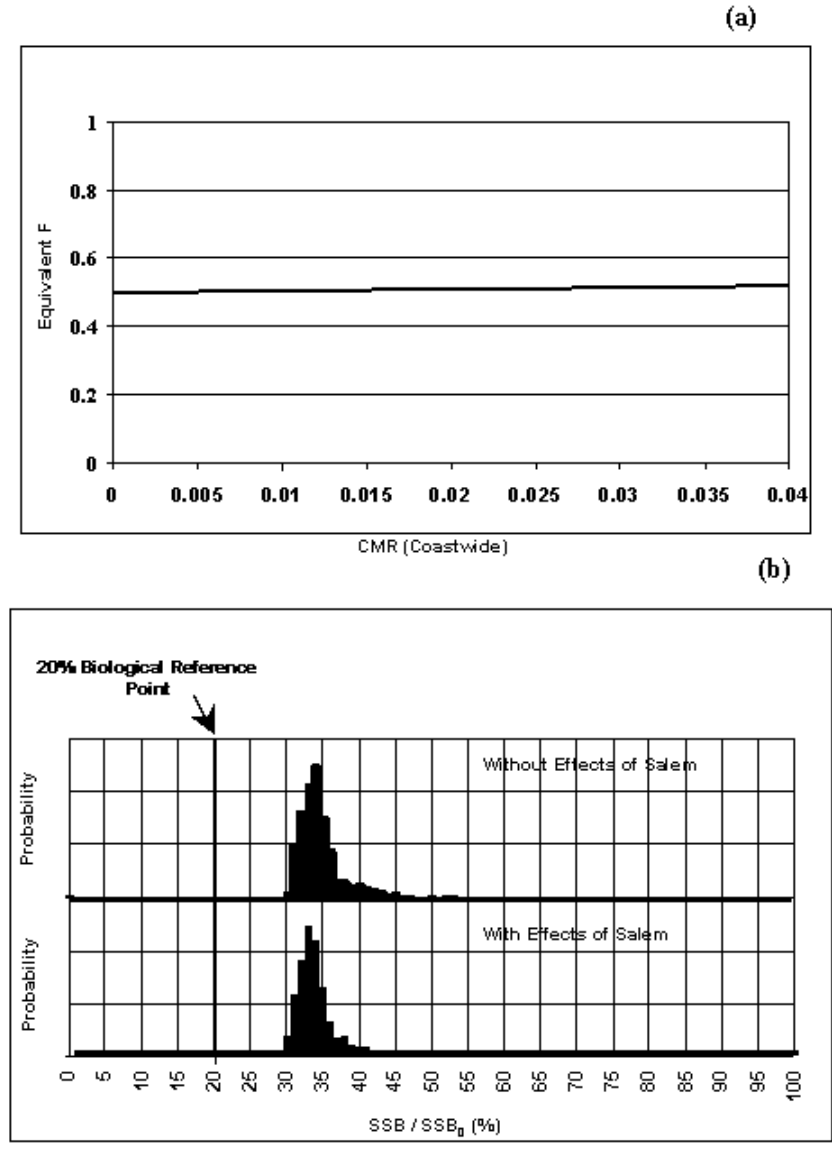
FIGURE 3. Results of stock jeopardy analysis for weakfish. Fig. 3(a) shows the influence of Salem on weakfish SSBPR, expressed as an incremental addition to the target rate of fishing for weakfish, for a range of assumptions concerning the coastwide CMR due to Salem. Fig. 3(b) shows the influence of Salem + fishing on weakfish SSB, expressed as a fraction of the equilibrium SSB for an unfished